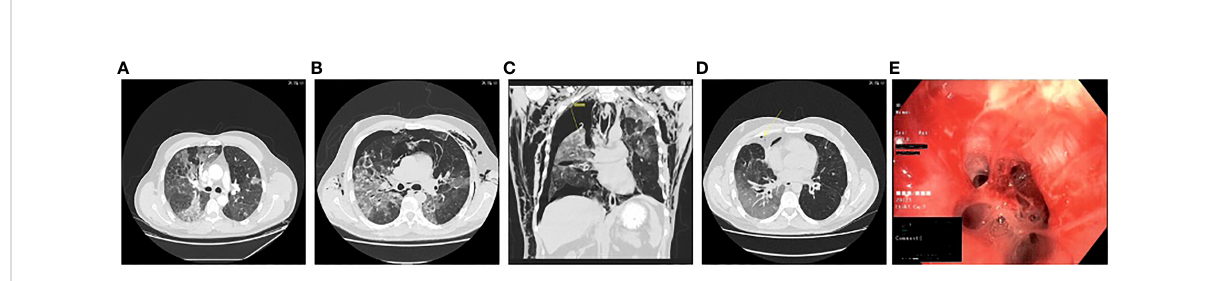
FIGURE 2 Computed tomography scans showing pulmonary in fi ltrates, pneumothorax and subcutaneous emphysema at (A) D50; (B) D70; (C) D93; (D) D153; and (E) clinical photo from bronchoalveolar lavage showing mucoid impaction at D63.